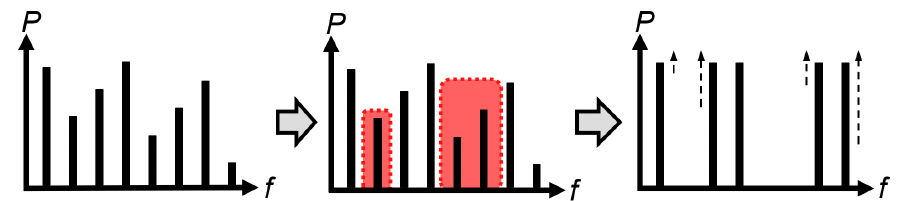
Figure 1. Basic operation, filtering, and amplification of digital repeater.